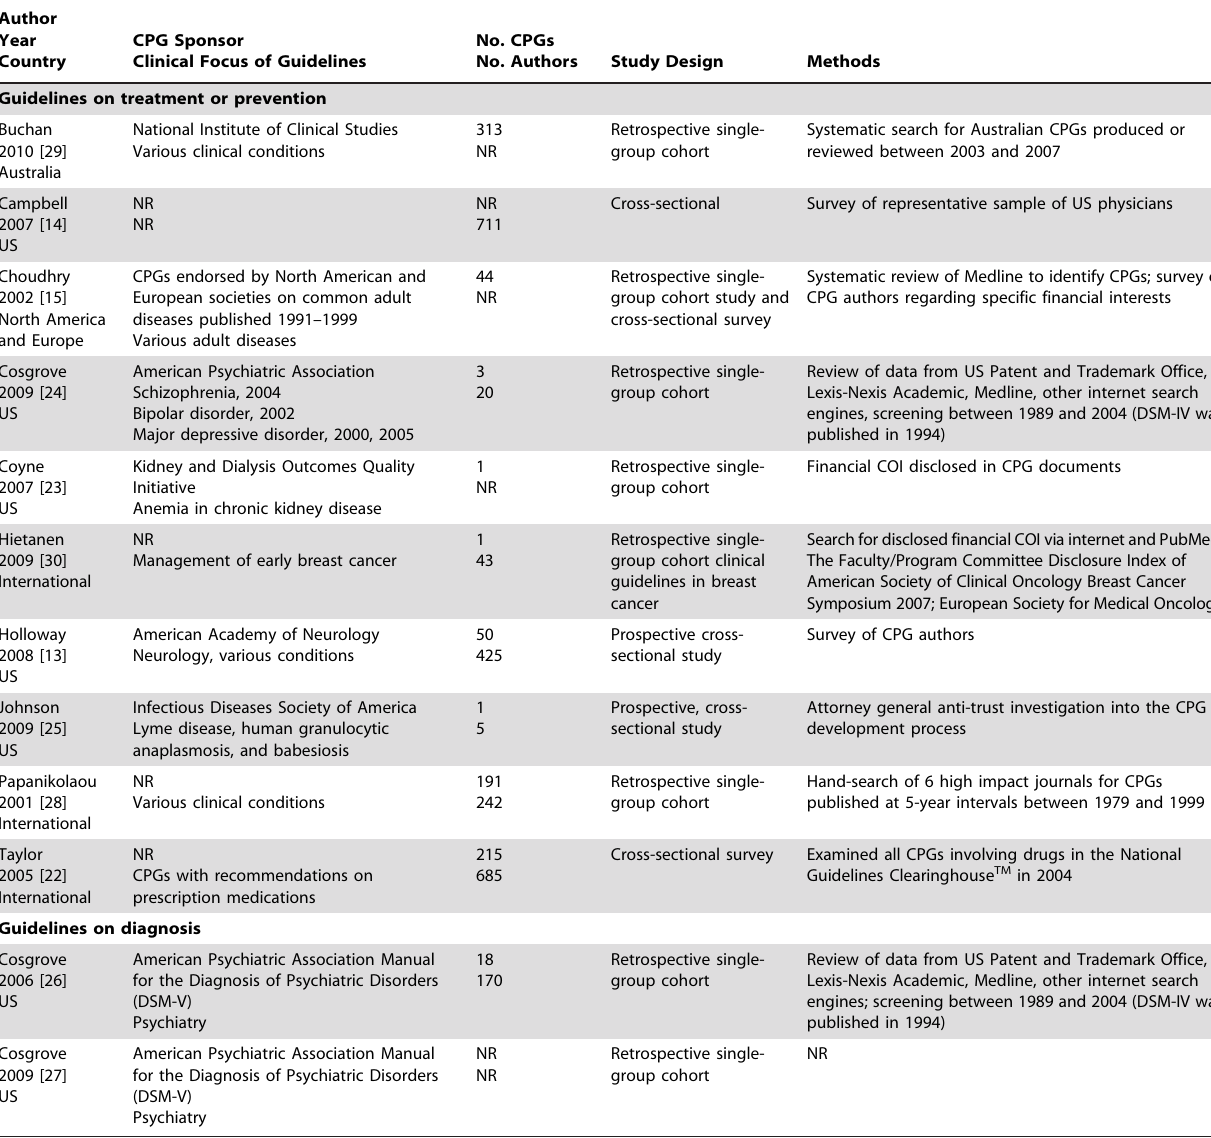
Table 1. Characteristics of included